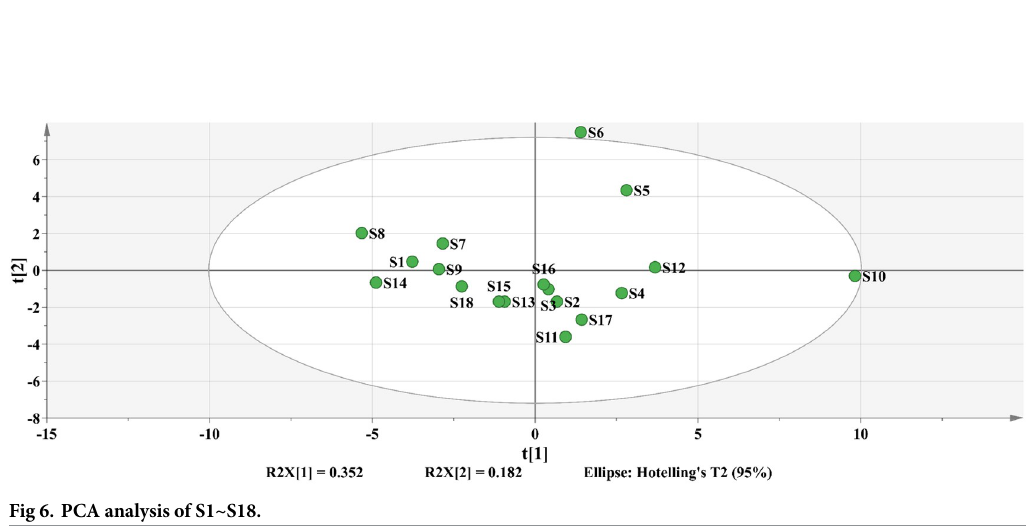
Fig 5. The chromatogram of S1 ~ S18 (common peak mode). R4: Gallic acid, R12: (+)—catechin, R35: Sennoside B, R47: Aloe emodin, R50: Rhein, R51: Emodin, R52: Chrysophanol, R53: Emodin methyl ether.